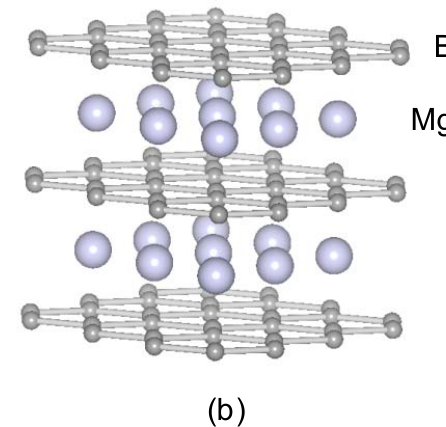
icosahedral unit in boron and (b) layer structure of MgB 12